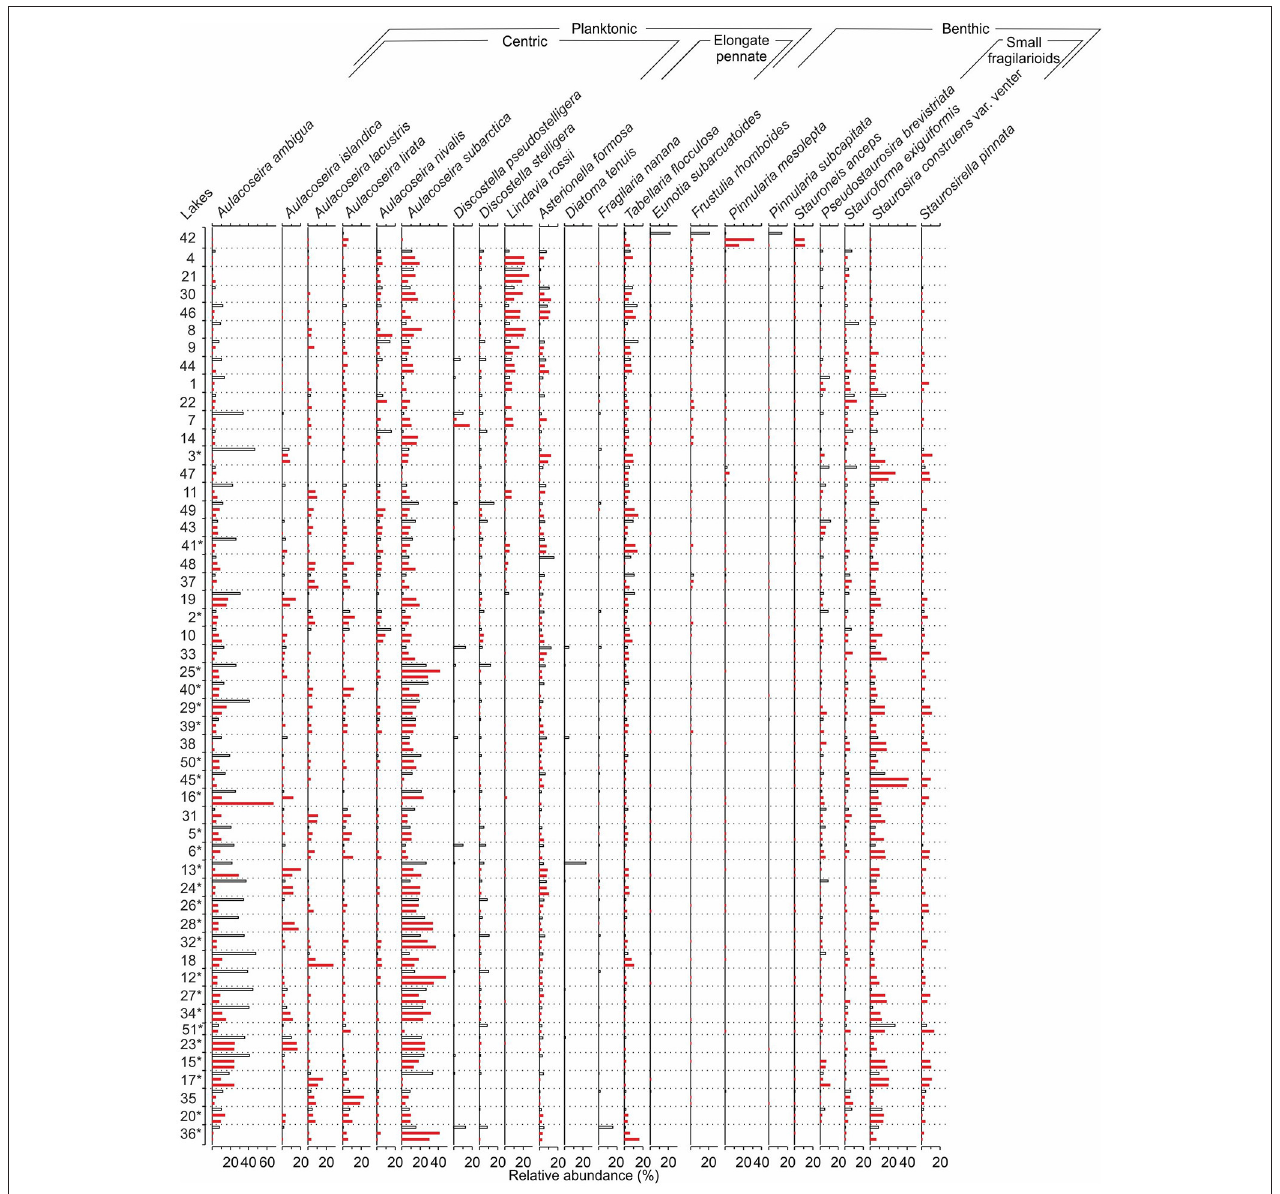
FIGURE 3 | A comparison between the bottom sample (red bars) and top sample (white bars) diatom assemblages for each sampling site. See Table 1 for the names and locations of the sites and Tammelin et al. (2017) for the description of the top sample data. The sampling sites are organized according to increasing bottom sample total phosphorus reconstructions. The Iisalmi Route sampling sites are marked with an asterisk. Taxa with a maximum relative abundance over 10% are included in the diagram.